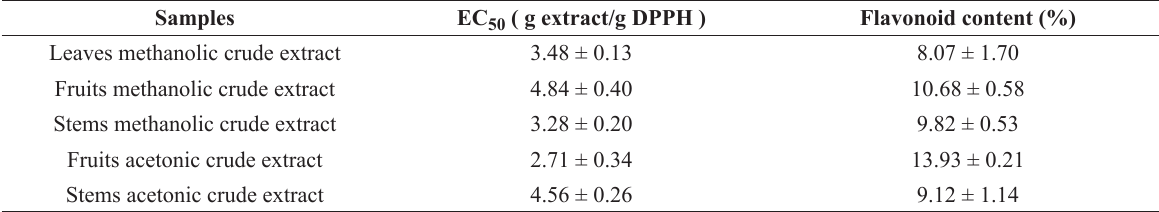
EC 50 values and flavonoid content of Clusia fluminensis crude